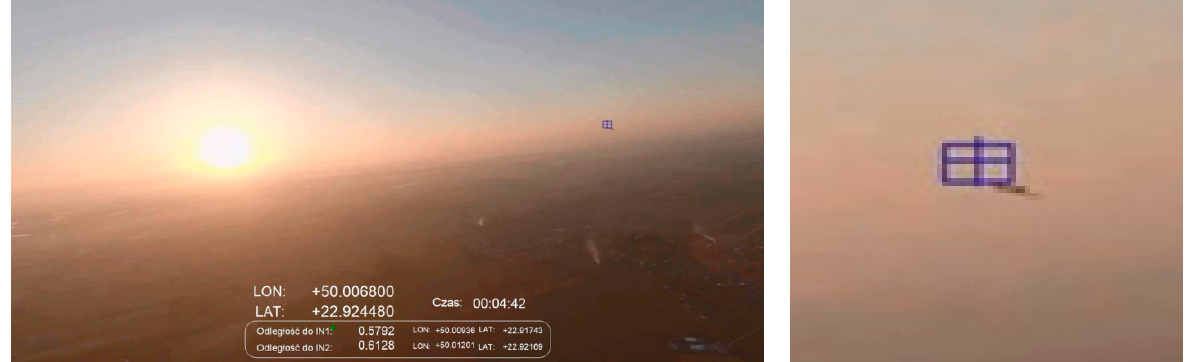
Figure 10. Scenario related to Figure 5C; sunset, altitude ~500 m, distance to intruder: 579 m.